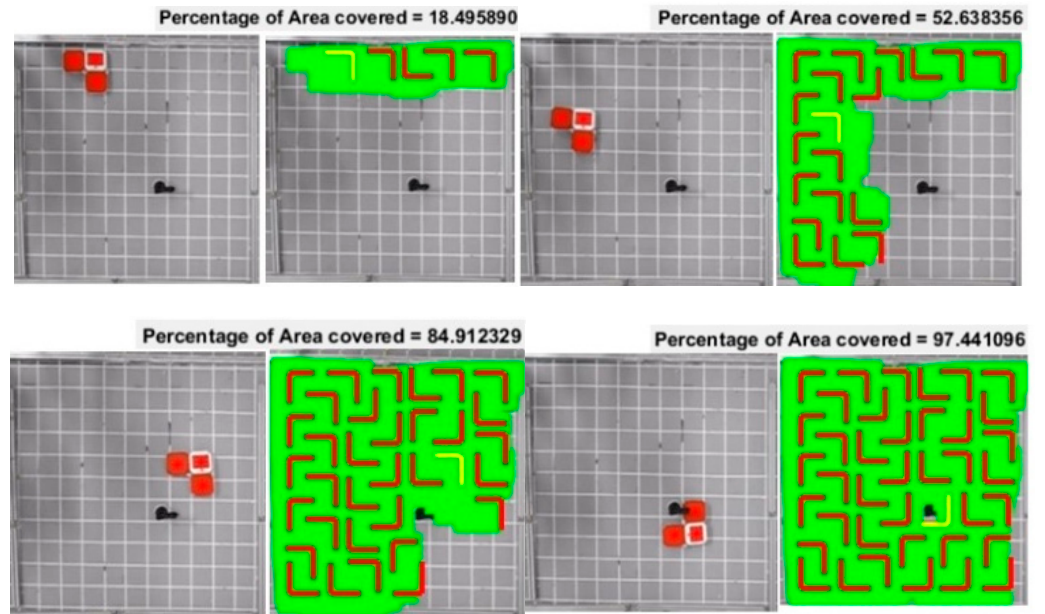
Figure 19. Tiling Process with Lemma 3 tile set.